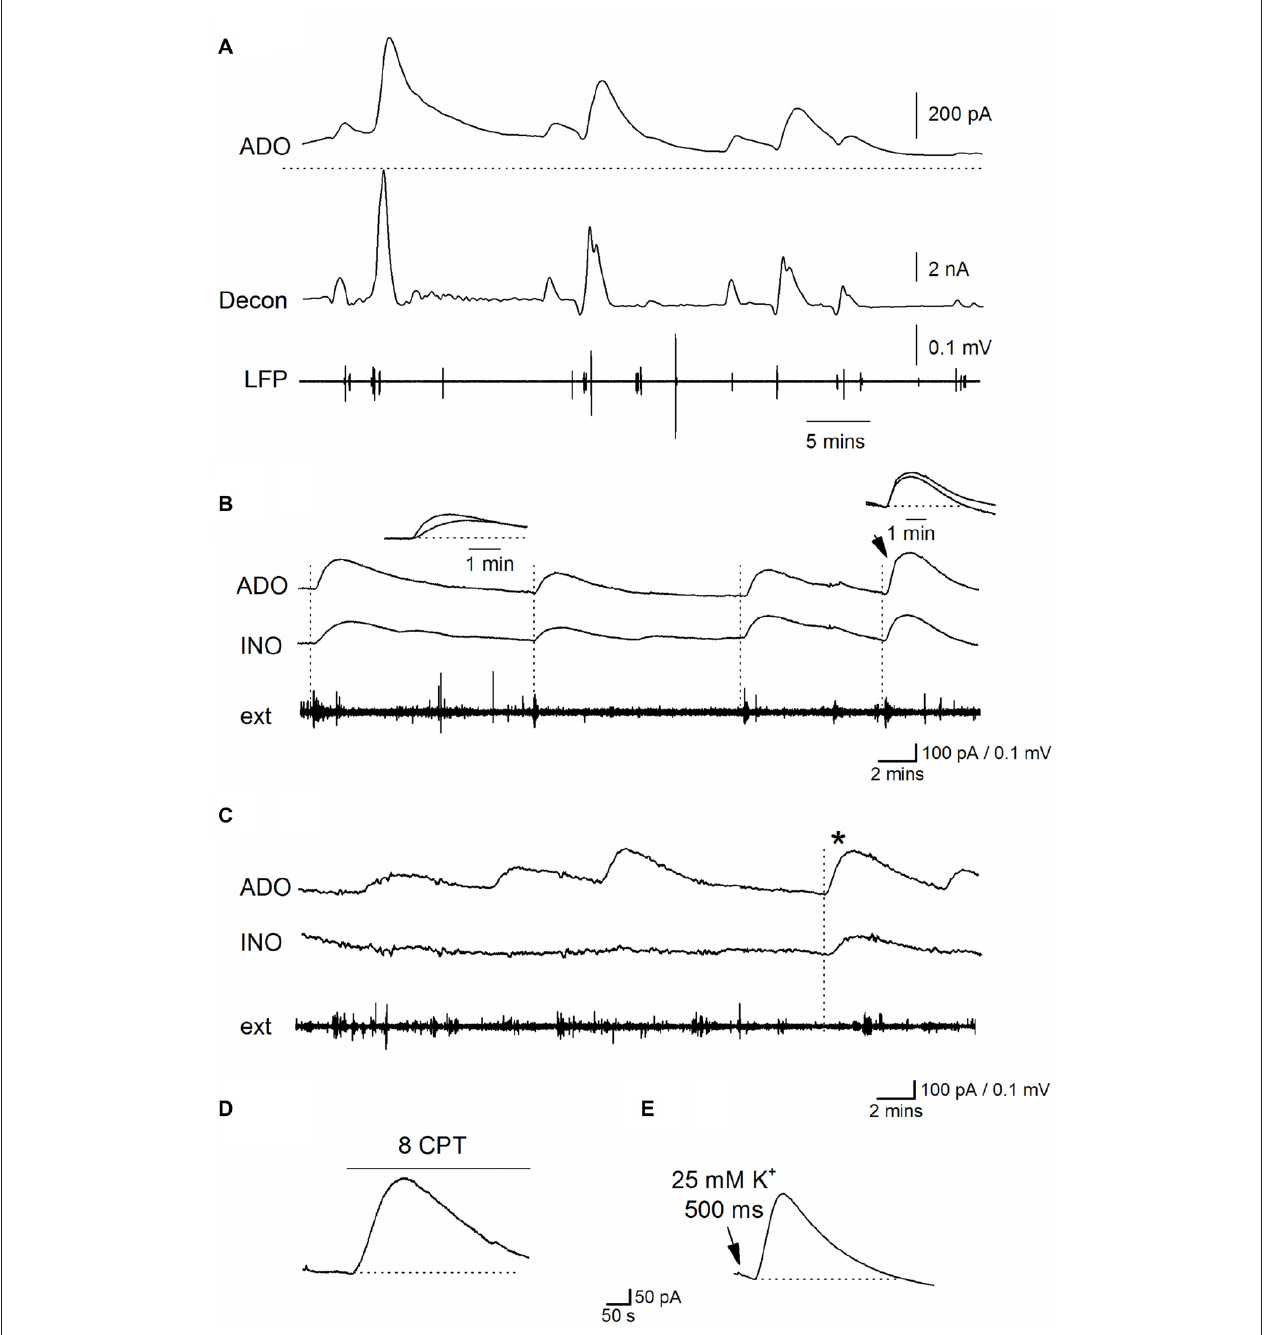
FIGURE 4 | Properties of spontaneous adenosine waveforms during established Ca 2 + -free activity. (A) Traces from an ADO biosensor during established Ca 2 + free activity. The top trace is the raw data showing spontaneous purine-release events, the dotted line shows the baseline current before activity began. The second trace (decon) shows the deconvolved trace where the slow component of decay ( τ = 180 s) of the release events has been removed separating the overlapping pulses and highlighting the release dynamic’s. The bottom trace (LFP) is the LFP signal which has been extracted from the biosensor current trace. (B) Traces from ADO and INO biosensors and an extracellular electrode. In this example, spontaneous purine-release events were observed on both ADO and INO biosensors and were weakly correlated with bursts of activity on the extracellular electrode (dotted lines). (C) Traces from ADO and INO biosensors and an extracellular electrode. In this example the majority of the release events were observed only on the ADO biosensor and not the INO biosensor. Furthermore the events did not correlate with activity recorded by the extracellular electrode. The asterisk shows an event measured on both biosensors. Thus in this particular slice most of the events appear localized near where the ADO biosensor was inserted. (D) Application of 8CPT (2 µ M) to block A 1 receptors produced a current on the ADO biosensor. (E) Puffing (500 ms puff duration) of Ca 2 + free aCSF with elevated K + (25 mM) onto area CA1 induced a current on the ADO biosensor which mimicked spontaneous release events.